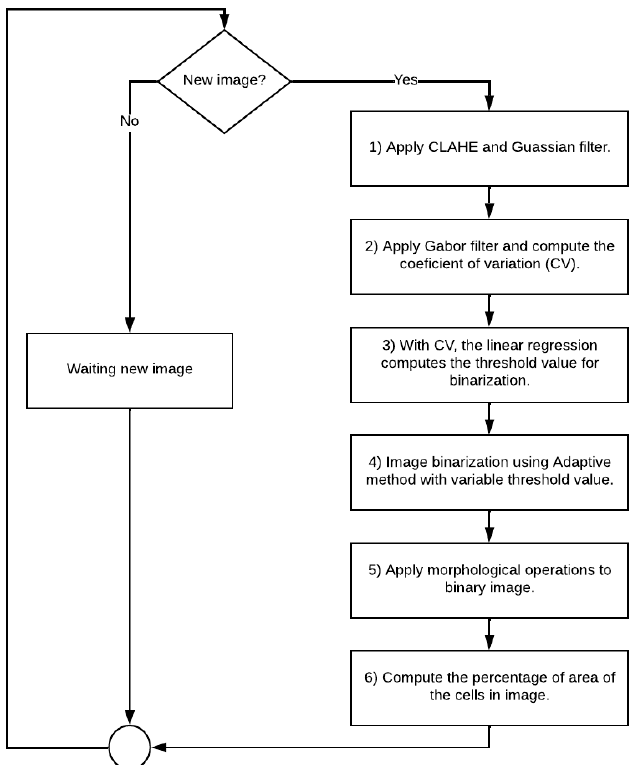
Figure 4. The GEMA flowchart used to segment MCF7 cells from image background.